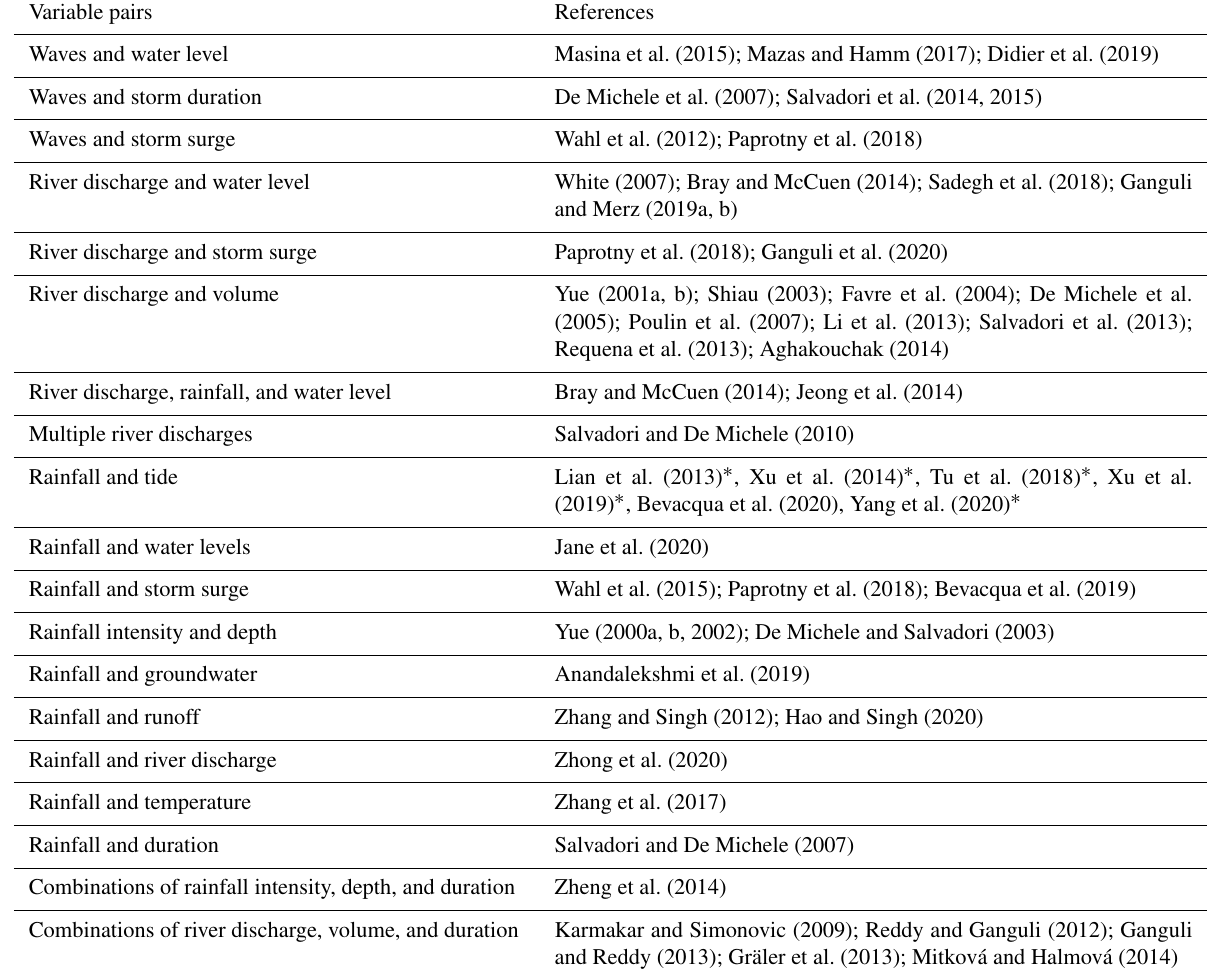
Table 1. A non-exhaustive list of multivariate studies which utilized copulas to study the associated variables. Variable